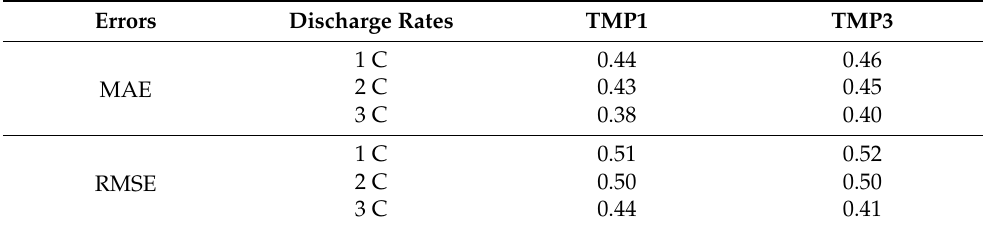
Figure 6. Model validation results: temperature of simulation and experiments at different discharge rates, ( a ) 1 C; ( b ) 2 C; ( c ) 3 C; ( d ) Relative errors. Table 3. The model MAE and